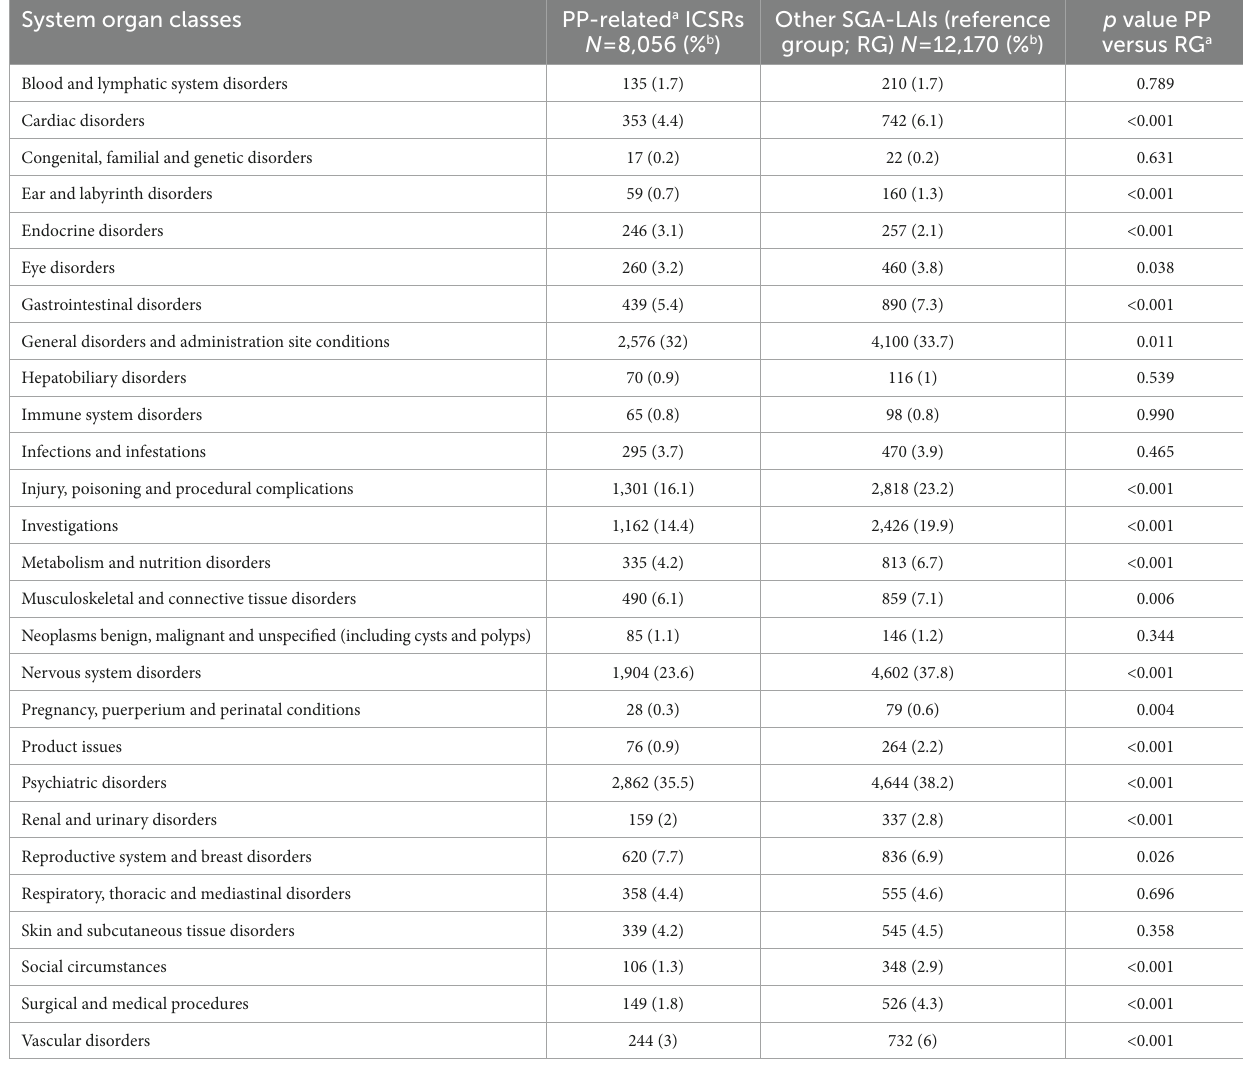
TABLE 2 Relative ADRs frequencies observed in PP-related ICSRs formulations as compared to reference group ICSRs, stratified by system organ